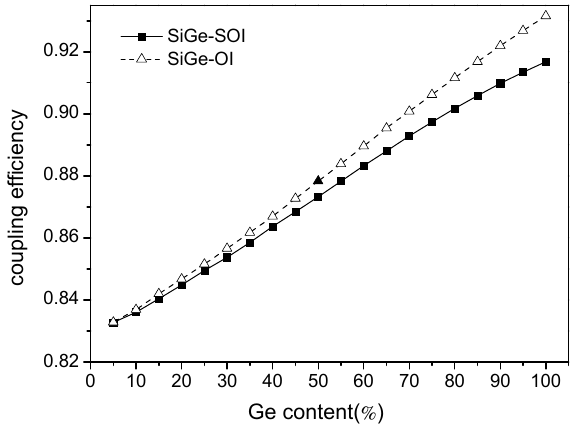
Figure 6. The relationship between coupling e ffi ciency and Ge content at the wavelength of 1.55 µ m. Figure 6 The relationship between coupling efficiency and Ge content at the wavelength of 1.55 μ m.